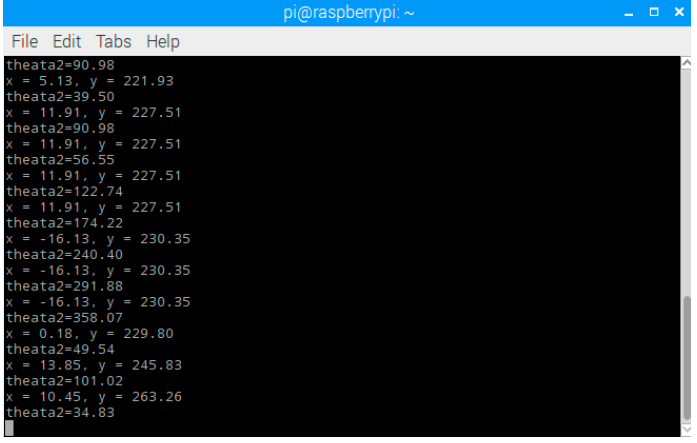
Figure 13. Remote observation interface.